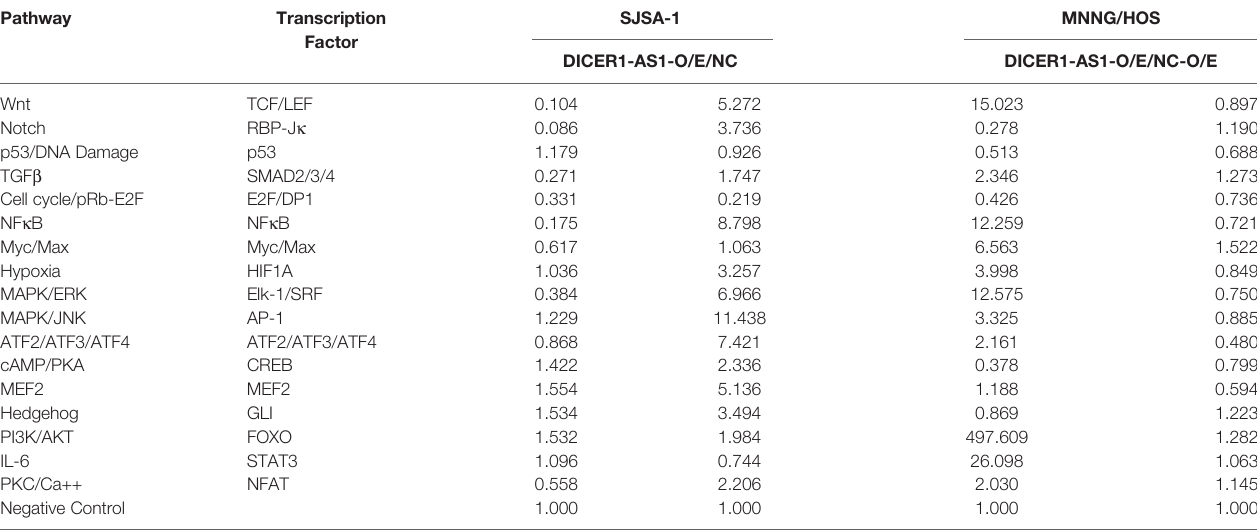
TABLE 1 | The activities of seventeen signaling pathways with overexpressed DICER1-AS1 in SJSA-1 and MNNG/HOS cells.